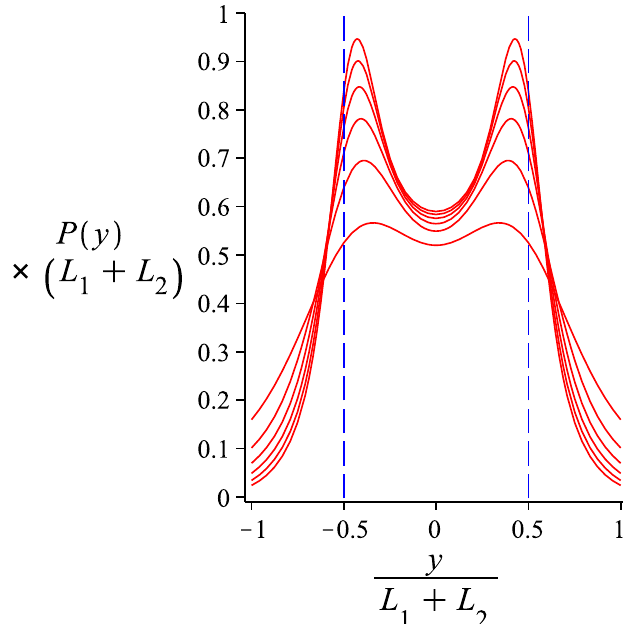
Figure 5. The probability density of the transverse component of the free end of a grafted system of two hinged WLCs. The curve is obtained from Equation (27). The varying parameter is l p ; bimodality of the curves. The fixed parameters are: L 1 = L 2 = 3 µ m, K h